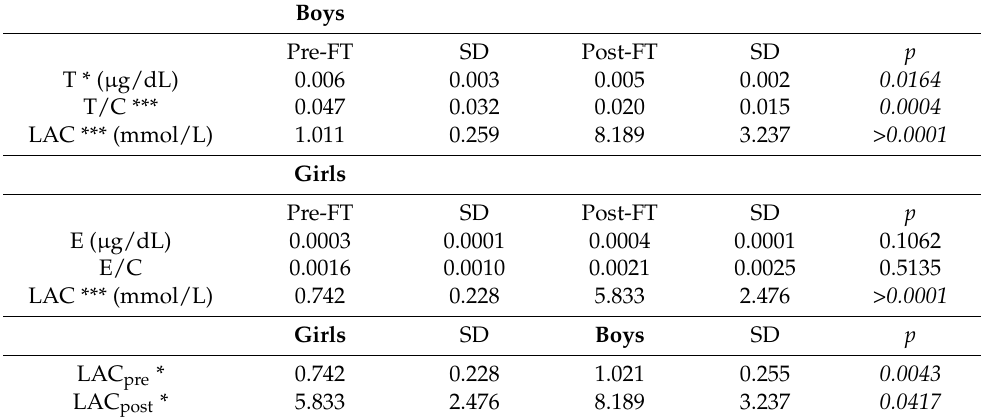
Table 1. Lactate and hormonal changes before and after the field test